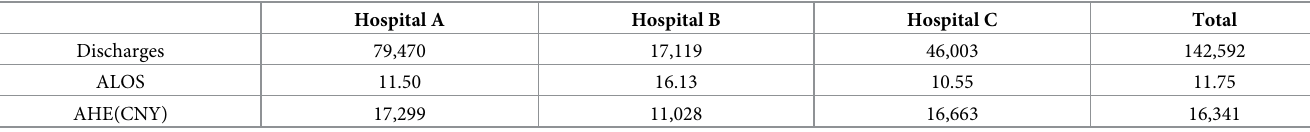
Table 3. Total number of discharges, ALOS and AHE of three hospitals’ discharges.